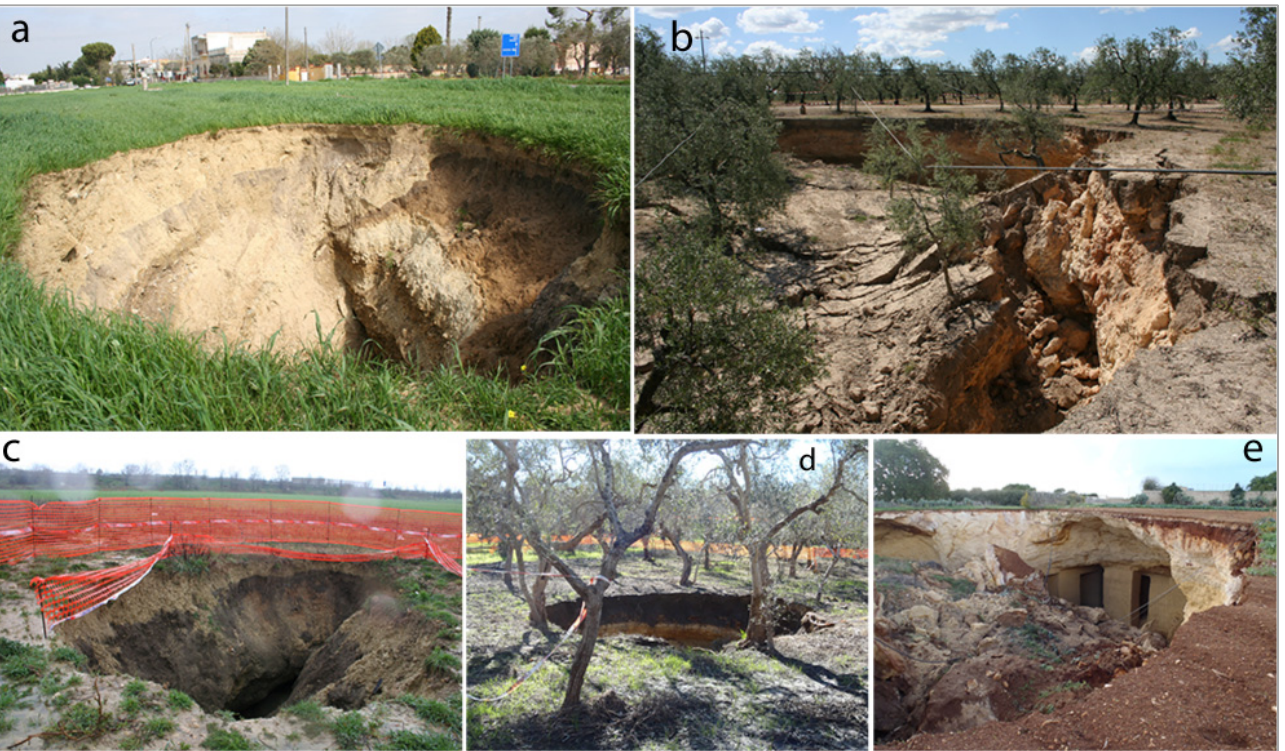
Figure 2. Sinkholes related to artificial cavities. All examples refer to underground calcarenite quarries, a rock material frequently used for building construction: ( a ) Cutrofiano, Apulia; ( b ) Barletta, Apulia; ( c , d ) Altamura, Apulia; ( e ) Marsala, Sicily.